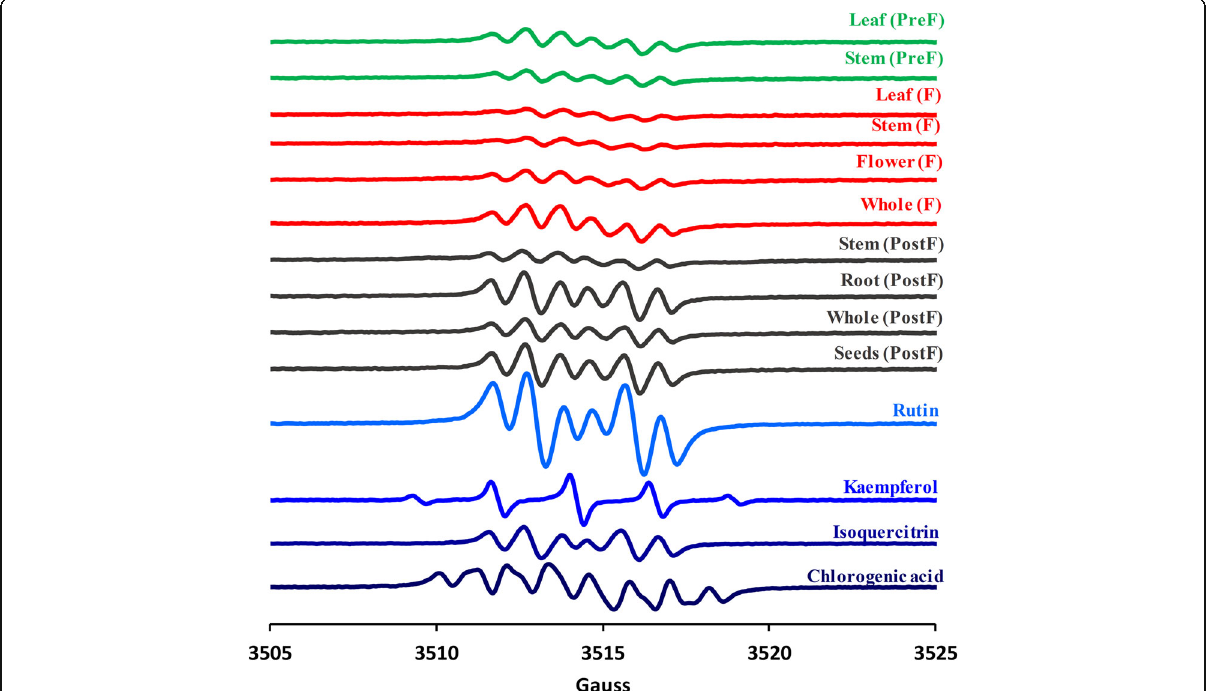
Fig. 3 EPR spectra of all ten studied extracts of H. capitatum and four most representative